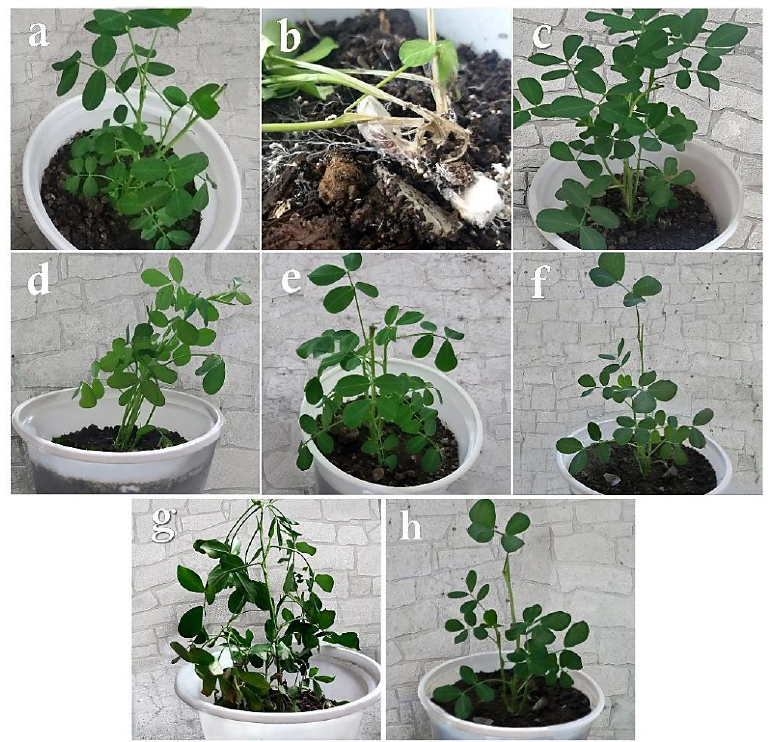
Figure 8. Greenhouse cultivation of A. hypogaea plants: ( a ) control plants treated with distilled water, ( b ) symptoms of the disease on the plants after inoculation only with Sclerotium rolfsii , ( c ) inoculation only with Trichoderma viride , ( d ) only with Aspergillus flavus , ( e ) only with Penicillium rubens (MN395854.1), ( f ) only with Penicillium rubens (MN395851.1), ( g ) only with Penicillium decaturense , ( h ) only with Trichoderma virens